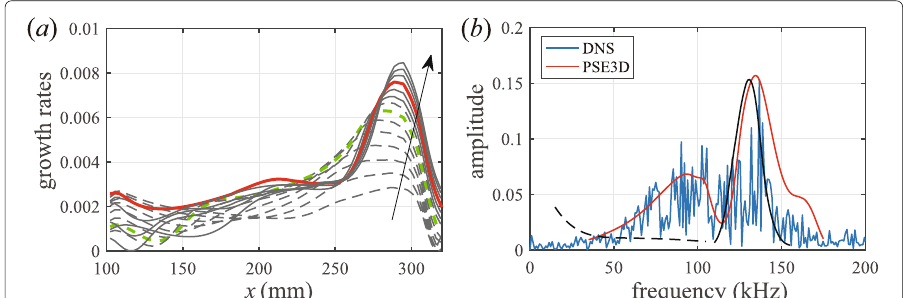
Fig. 2 ( a ) Evolution of growth rates of varicose modes obtained by PSE3D for various frequencies ranged from 35 kHz to 165 kHz with step of 10 kHz. The arrow indicates the increasing direction of frequency. The solid lines represent the second-varicose modes, while the dashed lines represent the first-varicose modes. The thick lines denote the largest components of the first- and second-varicose modes. ( b ) Comparison of spectra obtained by DNS (the transitional simulation) and PSE3D at x = 289 mm. The spectrum of DNS is obtained by Fourier analysis of the time series at the largest root-mean-square (rms) point in the center line of the primary streak, which is believed to be contributed by only varicose modes. The peak value of the PSE3D results is fixed to be equal to that of the DNS results. The spectrum obtained by the classical PSE (not accounting for the spanwise variations of the mean flow) for the laminar boundary layer (i.e., in absence of Görtler vortices) is also shown (black lines). The solid black line and dashed black line stand for the planar and oblique results (with the spanwise wavelength of 6 mm), respectively. Note that the dashed-line results have been magnified by